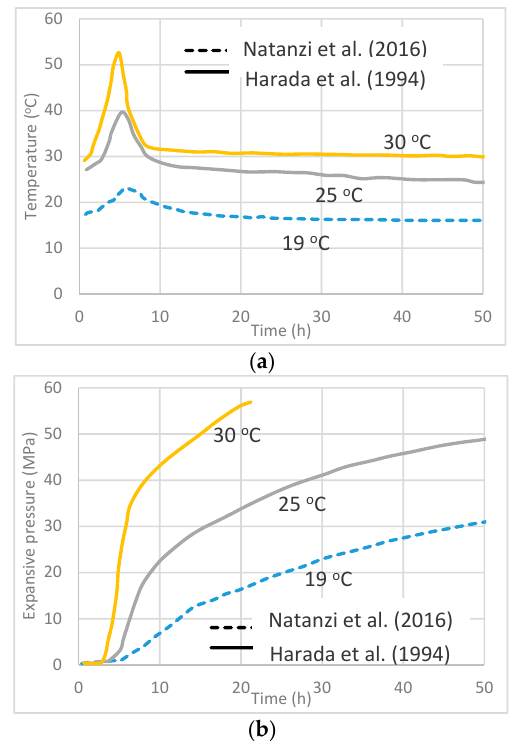
Figure 4. Effect of ambient temperature on expansive pressure ( a ) Temperature variation of SCDA with time; ( b ) Expansive pressure variation of SCDA with time [37,40].